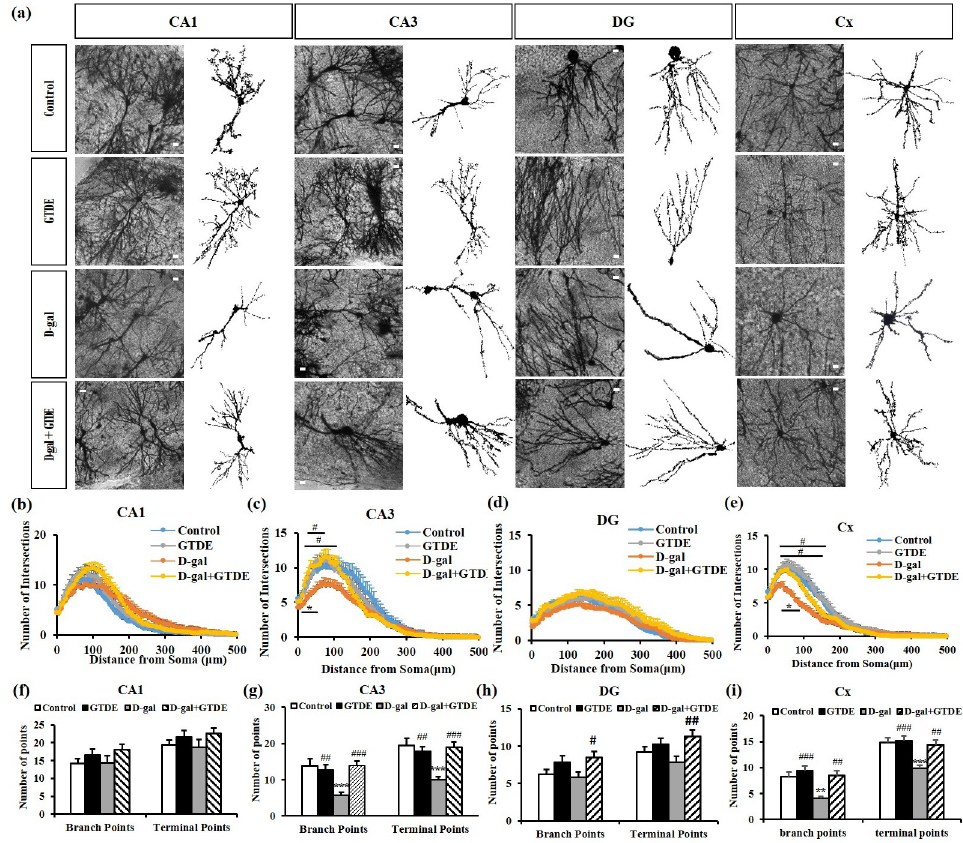
Fig 2. The aging-induced decrease in the number of dendritic branches in neurons of the hippocampus and cerebral cortex was attenuated by the administration of GTDE. (a) Morphology of neurons in the Golgi-stained hippocampal and cerebral cortical sections of the rats (scale bar = 50 μ m). (b) to (e) The results of (a) Sholl analysis for the (b) hippocampal CA1 region, (c) hippocampal CA3 region, (d) hippocampal dentate gyrus region, and (e) cerebral cortex. (f-i) Results of the analysis of the number of dendritic branch points and terminal points: (f) hippocampal CA1 region; (g) hippocampal CA3 region; (h) hippocampal dentate gyrus region; and (i) cerebral cortex. Intergroup differences were compared using one-way ANOVA followed by the Tukey’s multiple comparisons test. Statistically significant differences based on comparisons with the control group are denoted by � P < 0 . 05 , �� P < 0 . 01 , ��� P < 0 . 001 ; statistically significant differences based on comparisons with the D-gal group are denoted by # P < 0 . 05 , ## P < 0 . 01 , ### P < 0 . 001 . n (images) value (CA1, CA3, DG, Cx) = control (21,21,22,23); GTDE(16,14,18,25); D-gal (16,16,19,23); D-gal+GTDE (18,17,16,23).